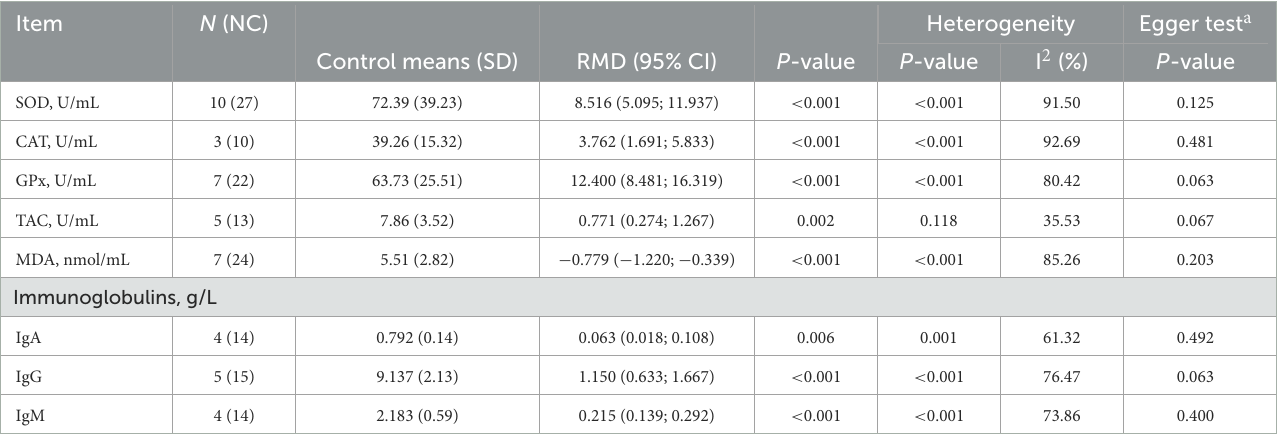
TABLE 3 Oxidative status and immune response of cattle supplemented with flavonoids.